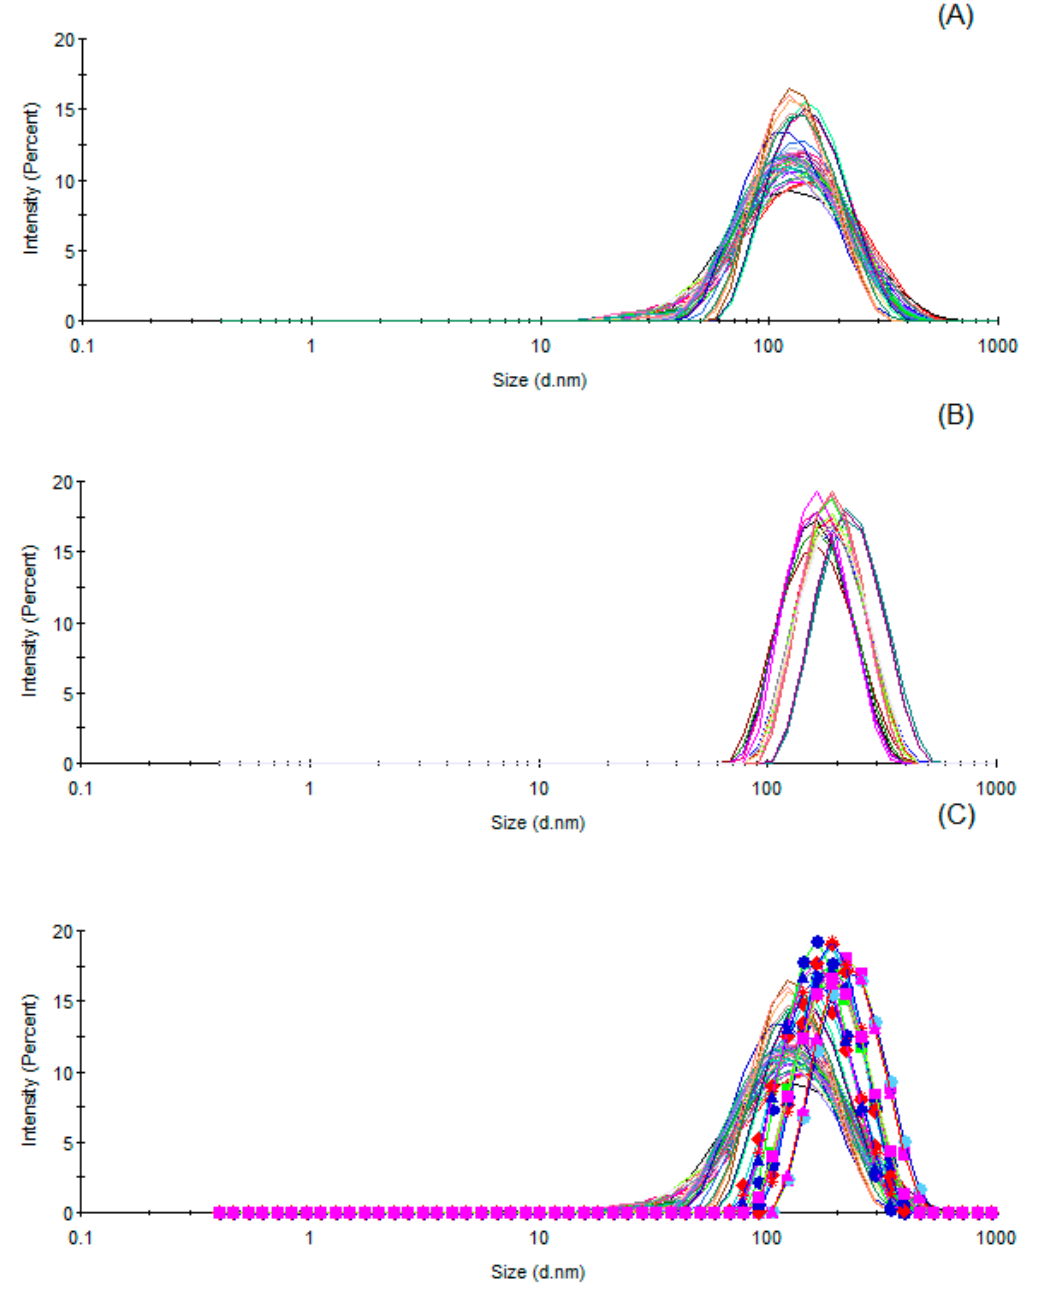
Figure 2. Droplet size distribution graphs of the Pectis elongata-based nano-emulsion. Superimposed graphs show measurements after ( A ) 0–30 days of storage, ( B ) 60–90 days of storage and ( C ) 0–90 days of storage. Colors representing size distribution curves of three independent batches of the prepared nano-emulsions. Measurements were performed in triplicate.